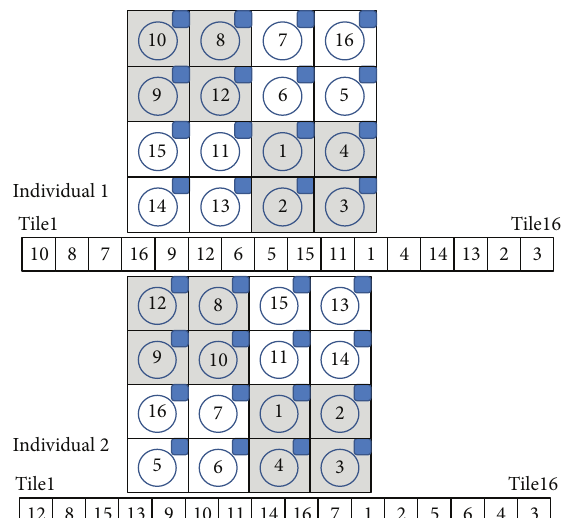
Figure 3: Partition and core placement of VOPD application for NP initial population in GA and the associated integer